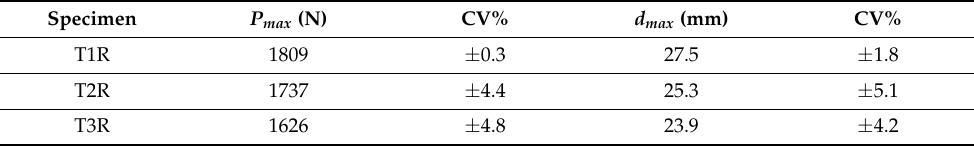
Figure 8. ( a ) Flexural strength of each specimen. ( b ) Maximum flexural deflection of each specimen .